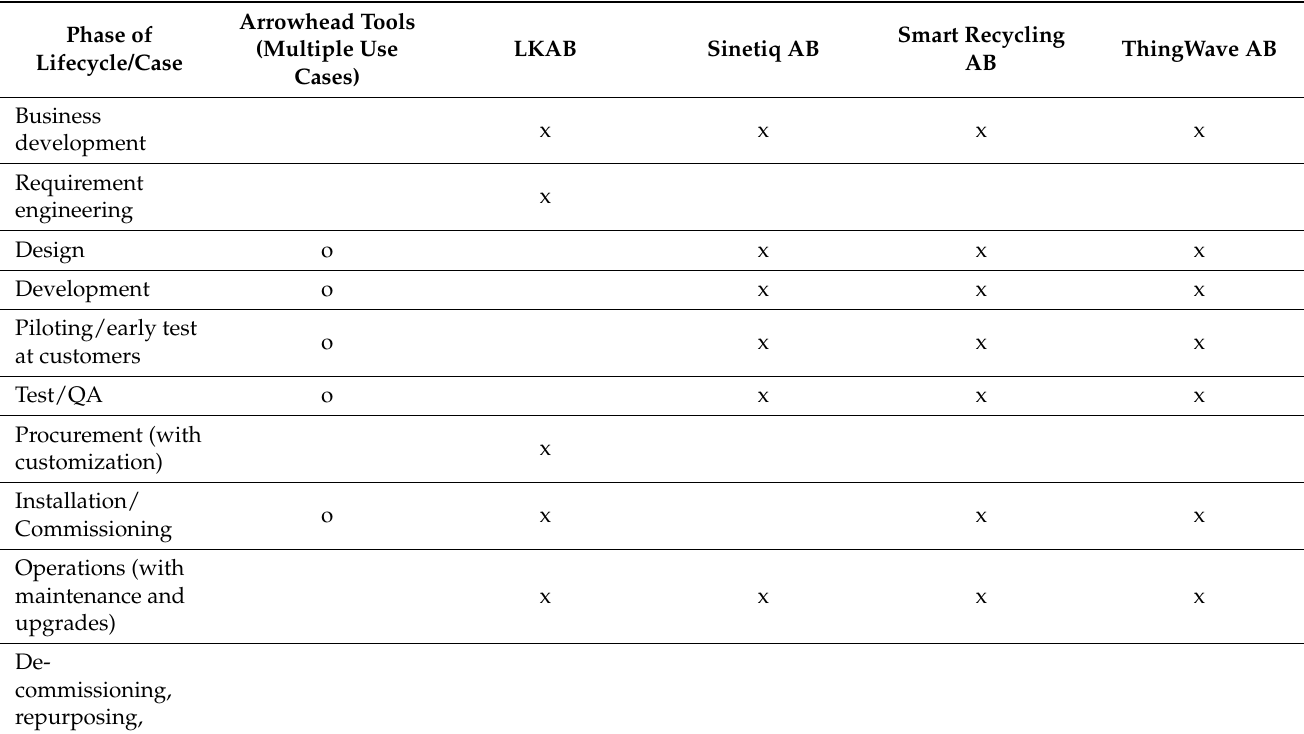
Table 2. Visualization of results and summary of